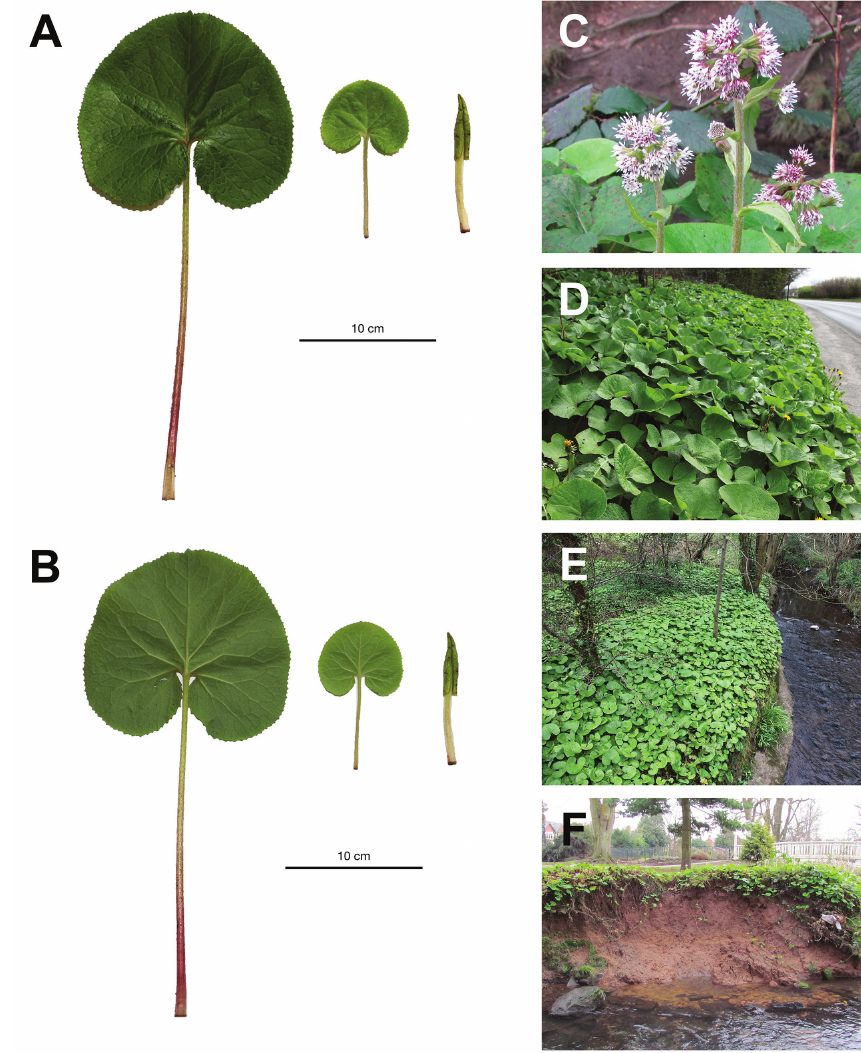
Figure 1. P. pyrenaicus - Winter Heliotrope. Where A adaxial and B abaxial leaf surfaces (immature leaf and leaf bud is also shown). Leaves are suborbicular and not lobed; up to 20 cm across, petioles to 30 cm C inflorescence (November-February). Erect flowering stems (to 30 cm) bear few medium-broad bracts and a panicle of capitula; flowers are white tinged purple and strongly almond-scented D and E low growing, compact, closed canopy of leaves growing adjacent to a road ( D ) and stream ( E ) F P. pyrenaicus growing on the bank of Roath Brook (Cardiff, UK). Note depth of rhizome system (bank is ~2 m above the river chan- nel), that the majority of rhizome is concentrated in the top 50 cm of the soil profile and erosion of the riv- erbank due to ineffective binding of soil by P. pyrenaicus rhizomes and roots. (Images courtesy of D.